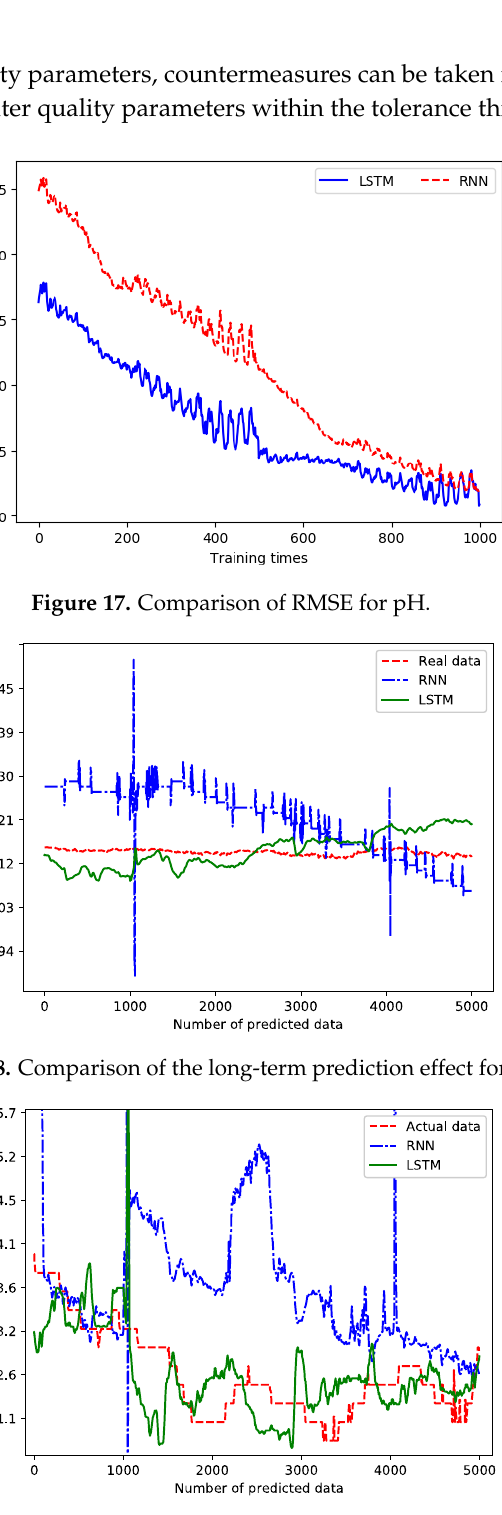
Figure 19. Comparison of the long ‐ term prediction effect for water temperature.